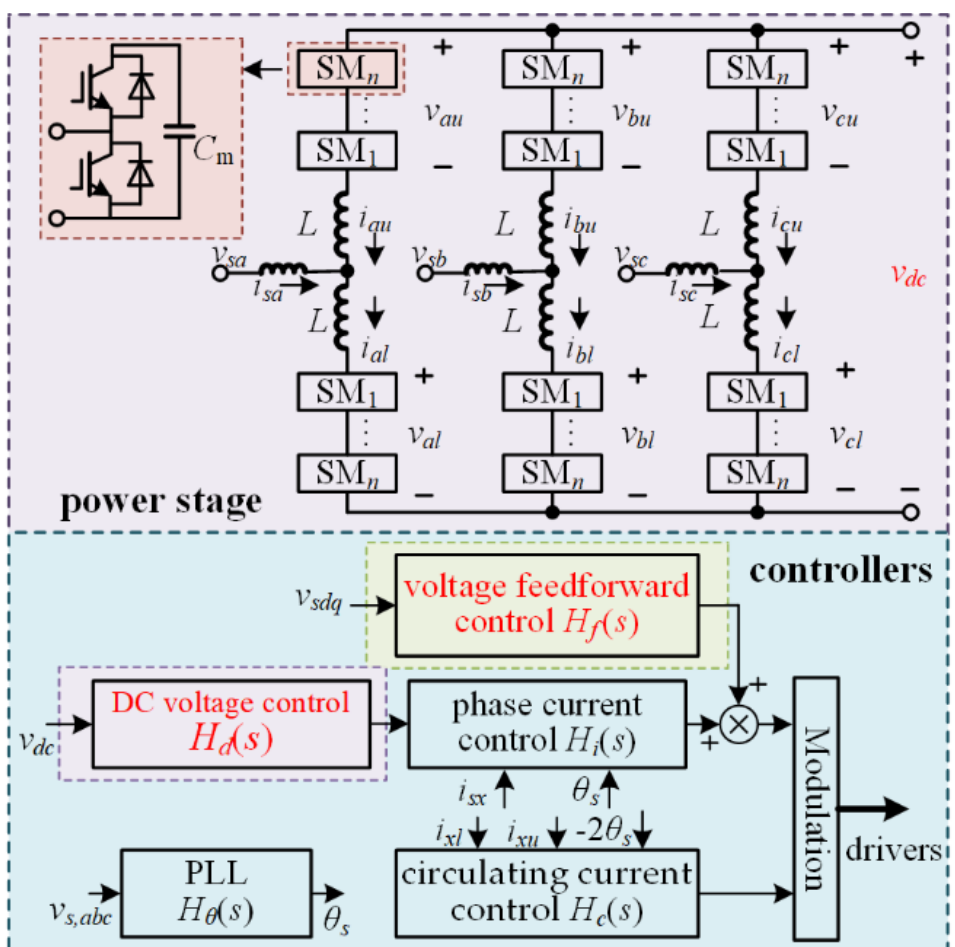
Figure 1. Power stage circuit and control diagram of MMC-HVDC considering DC voltage control and voltage feedforward control.